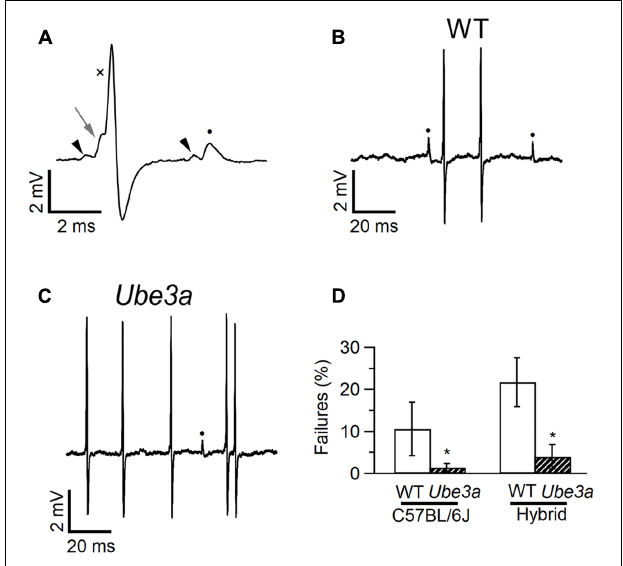
FIGURE 4 | Fewer failures in MNTB neurons of Ube3a mice. (A) Two complex waveforms from principal neuron of a C57BL/6J WT mouse recorded in the juxtacellular configuration, showing a suprathreshold eEPSP (left gray arrow), which triggers an eAP (cross), and a subthreshold eEPSP (closed circle), which is not followed by an eAP. Both eEPSPs are preceded by a prespike (black arrow heads). (B) Same recording as A , illustrating the presence of both subthreshold (filled circles) and suprathreshold events. (C) Similar as B , but from a Ube3a E113X mouse. (D) Comparison of spontaneous failure percentages of WT and Ube3a mice from two genetic backgrounds. ∗ Indicates p < 0.05 (Mann–Whitney U